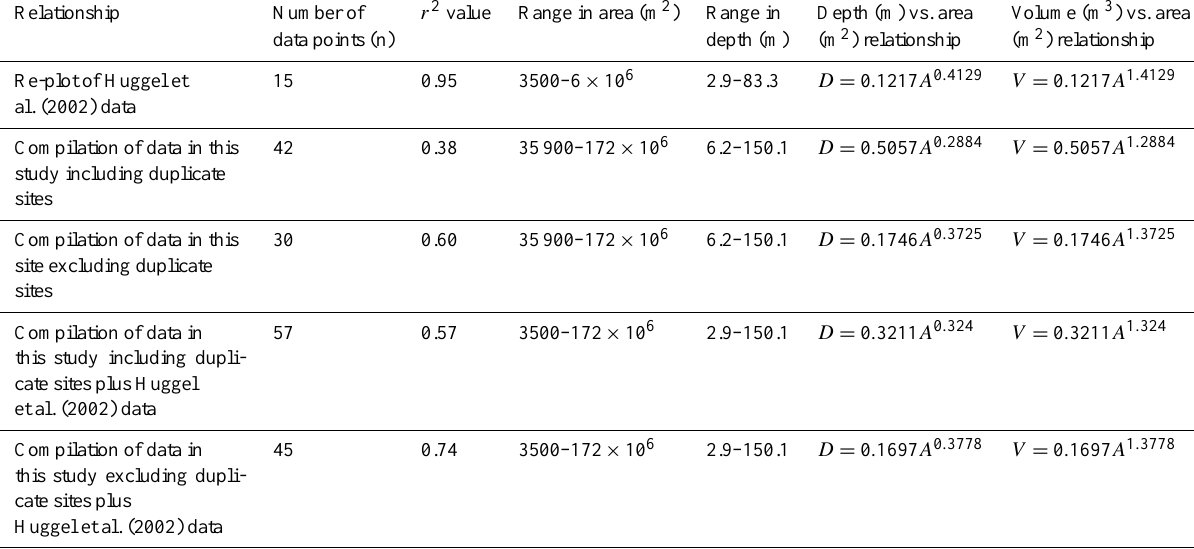
Table 1. Summary of relationships derived from measured lake area and depth